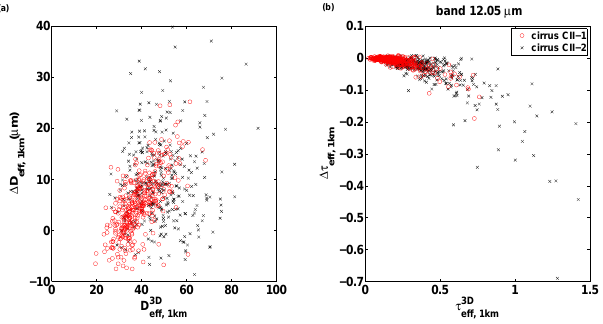
Figure 10. (a) Errors on the retrieved effective diameter (cid:49)D eff, 1 km as a function of the effective diameter, D 3-D (b) error on the effective optical thickness, (cid:49)τ eff, 1 km , as a func- tion of the effective optical thickness, τ 3-D CII-2.